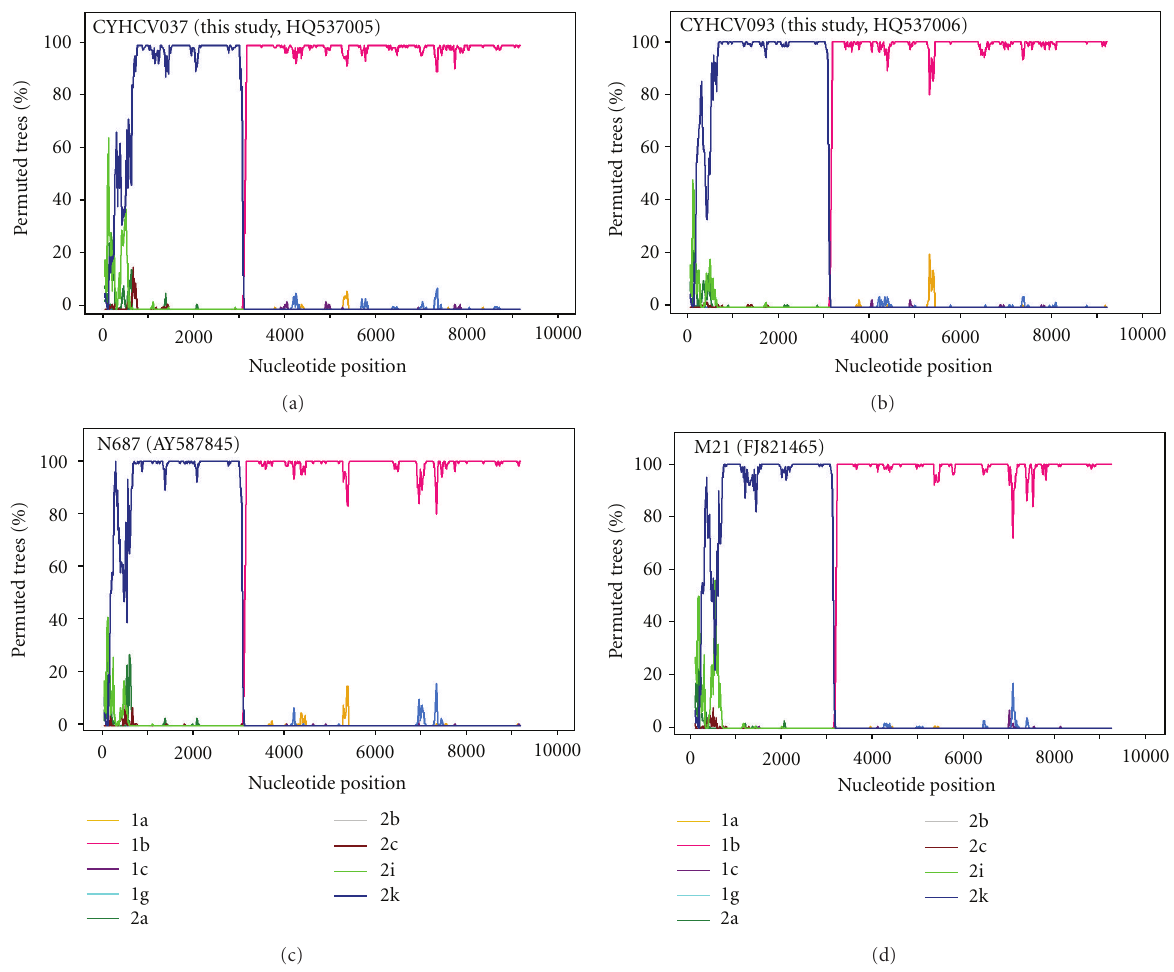
Figure 2: Bootscan plot of percentage permuted trees over nucleotide position across the full length of the 2k/1b recombinant strains. (a, b) are for the strains described in this study and (c, d) for the only near-full 2k/1b genomes submitted to GenBank to date. Strain identifiers are indicated at the top left corner of each plot. In brackets are the GenBank accession numbers of the sequences. The annotation below shows the HCV subtype of the consensus sequences corresponding to each line colour in the